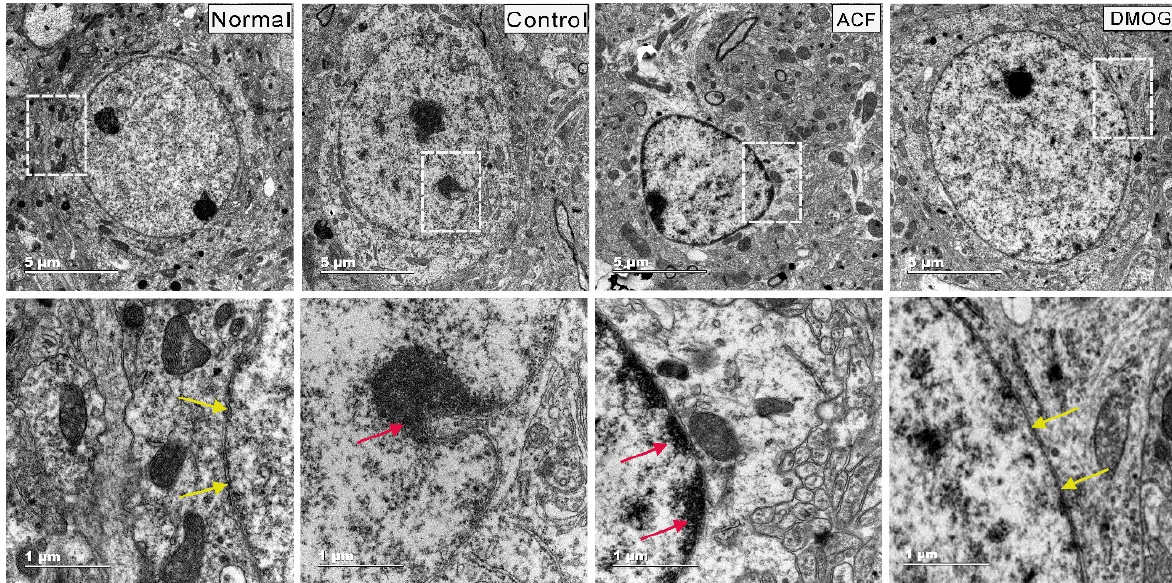
Figure 5. HIF-1 activation possesses a neuroprotective effect post-stroke. ( A ) NeuN immunostaining. ( B ) Number of NeuN positive cells post-stroke. Control vs. Normal; ** p < 0.01, ACF vs. Control; p = ns, DMOG vs. Control; ** p < 0.01. Scale bar 50 μ m and 20 μ m. All values are expressed as mean ± SEM, One-way ANOVA with post hoc Tukey test, n = 5.